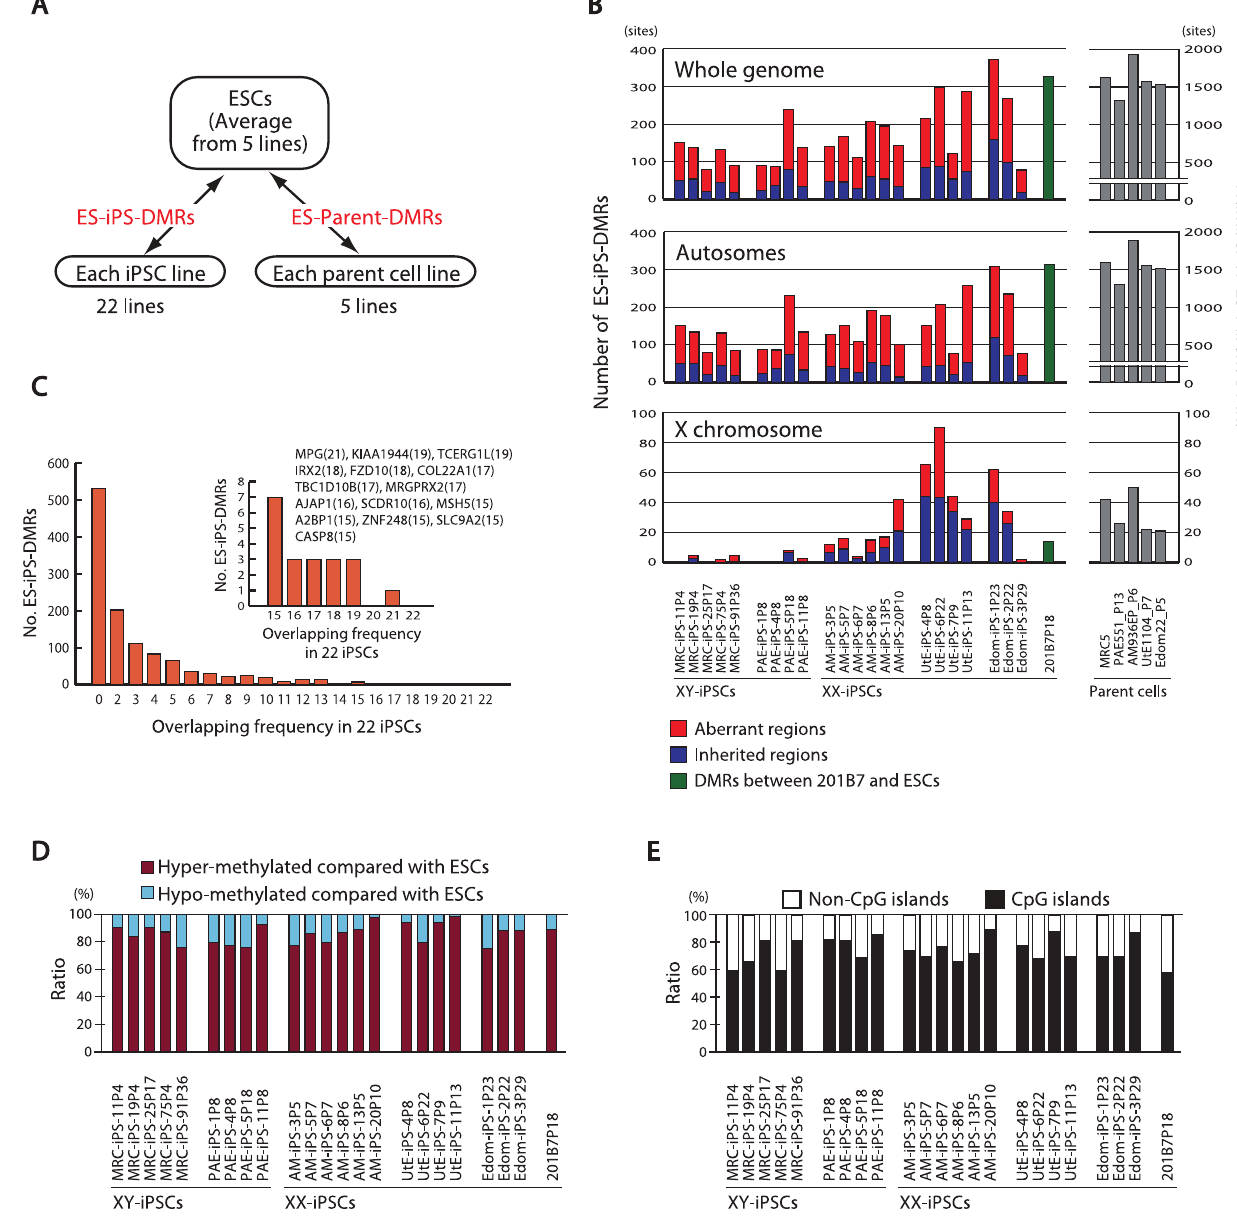
Figure 3. Aberrant methylation in human iPSCs. ( A ) Comparison of DNA methylation states of each iPSC line or each parent cell line with that of ESCs. The DMRs between ESCs and iPSCs are designated as ES-iPS-DMRs, and the DMRs between ESCs and parent cells are designated as ES- parent-DMRs. ( B ) The number of ES-iPS-DMRs and ES-parent-DMRs on whole genome (top), autosomes (middle) and X chromosome (bottom). Ratios of number of inherited regions in iPSCs from parent cells (blue) and aberrant regions in iPSCs that differ from ESCs and parent cells (red) in the ES-iPS- DMRs are shown in bars. Female iPSCs were demonstrated to carry high number of EiP-DMRs on X chromosome. ( C ) Number of overlapped ES-iPS- DMRs frequency in iPSCs. No overlapping ES-iPS-DMRs in all 22 iPSC lines. (Inlet) A small number of overlapping ES-iPS-DMRs of the frequency from 15 to 22. Overlapping frequency of each gene is indicated in parentheses. ( D ) Proportion of the hyper- and hypo-methylated ES-iPS-DMRs. More than 75% of the ES-iPS-DMRs were hyper-methylated in iPSCs. ( E ) Proportion of the ES-iPS-DMRs associated with CpG islands and non-CpG islands in ach iPSC line. ES-iPS-DMRs were biased to CpG islands.